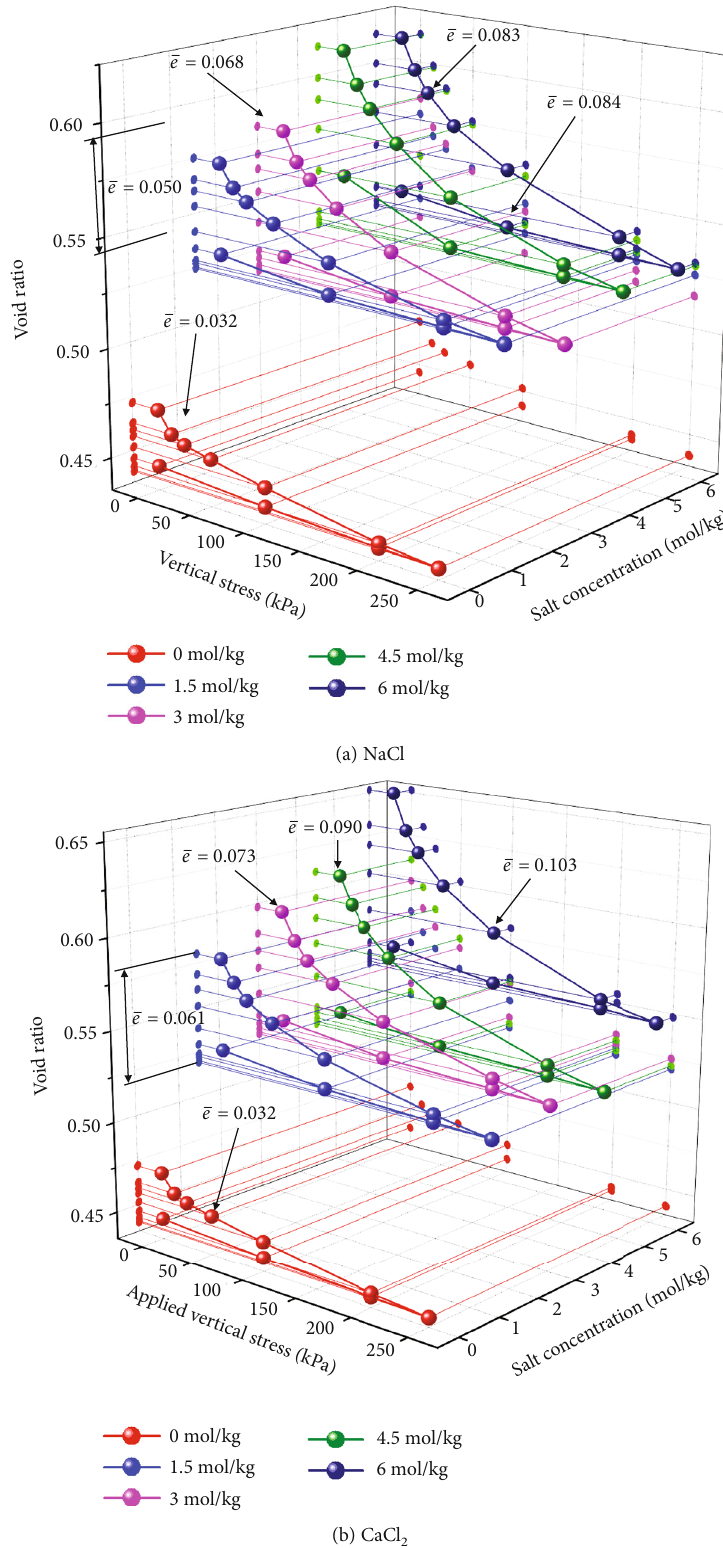
Figure 7: Compression curves of di ff erent saline soils ( (cid:1) e : maximum change of void ratio during